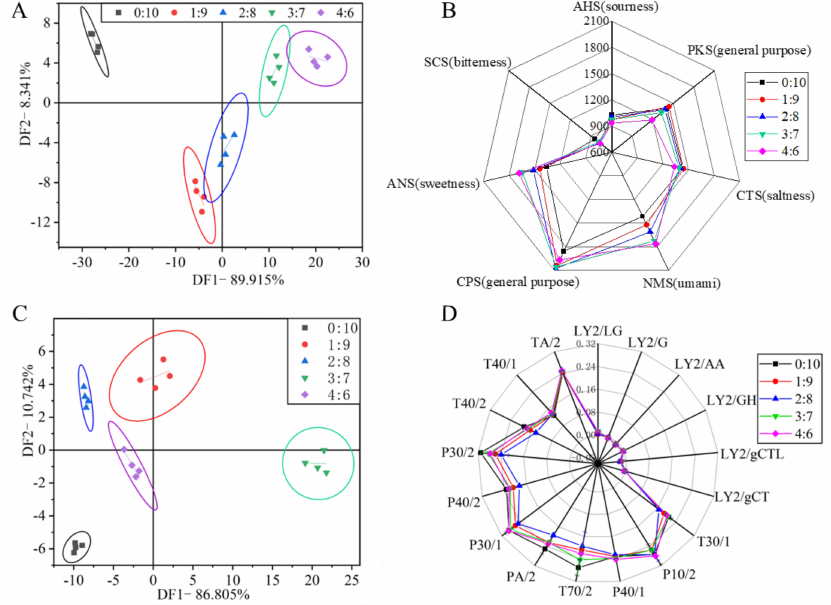
Figure 6. Flavor profiles of extrudates with different surimi to soybean flour ratio. DFA diagram ( A ) and radar graph ( B ) of E—tongue data; DFA diagram ( C ) and radar graph ( D ) of E—nose